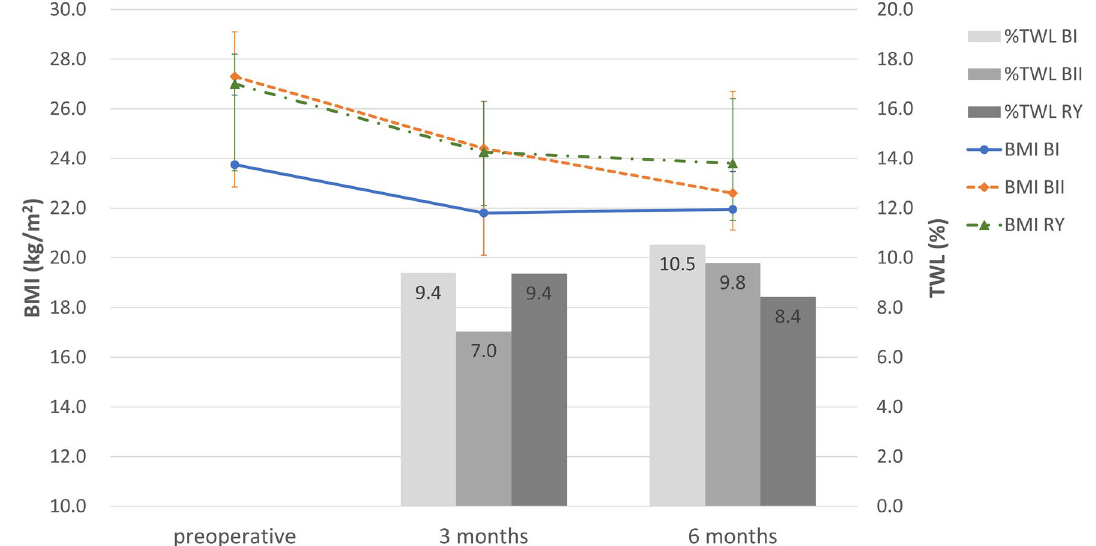
Figure 3. Changes in anthropometric data during the follow-up period after surgery ( BMI body mass index, %TWL percentage of total weight loss, BI Billroth I, BII Billroth II, RY Roux-en-Y).